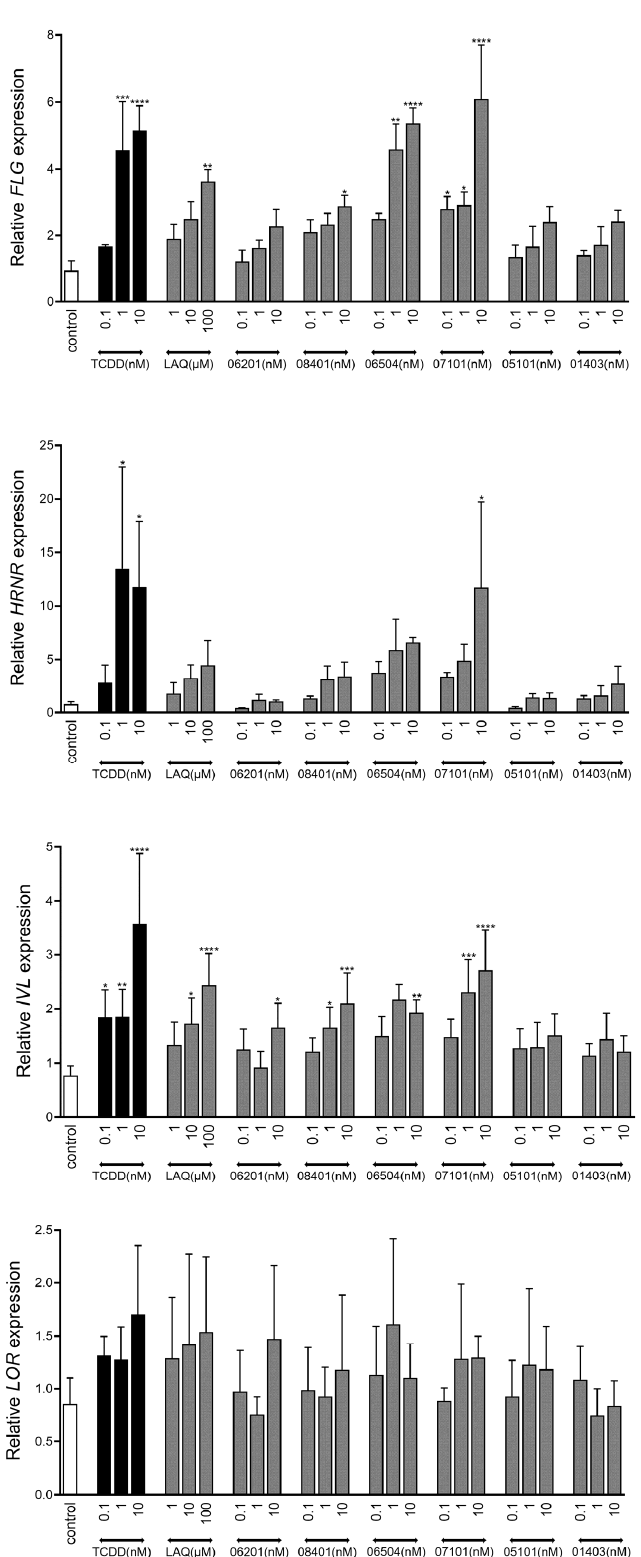
1 Figure 3. Upregulation of epidermal differentiation in vitro. Expression analysis of terminal dif- ferentiation genes filaggrin ( FLG ), hornerin ( HRNR ), involucrin ( IVL ), and loricrin ( LOR ) after 48 h stimulation (re-stimulation after 24 h) of monolayer primary human keratinocytes ( n = 3) with a concentration series of the IMA-compounds, LAQ, and TCDD. * p < 0.05, ** p < 0.01, *** p < 0.001, **** p < 0.0001. Mean +/ −